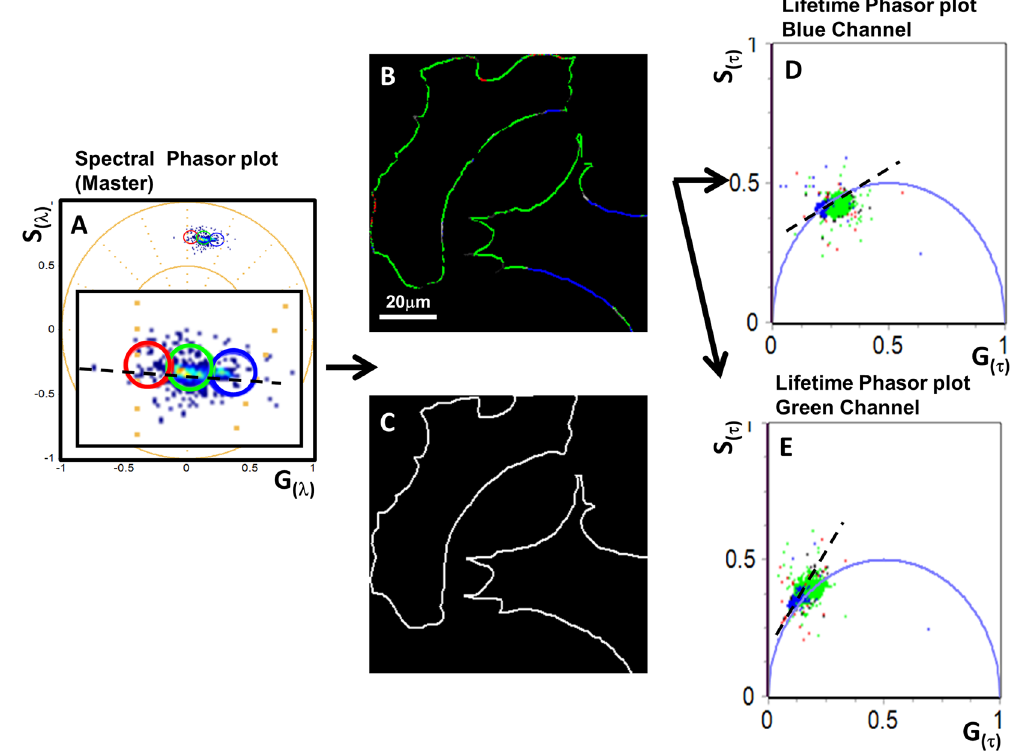
Figure 4. Multi-D phasor analysis of the LAURDAN fluorescence in NIH-3T3 plasma membranes. ( A ) Spectral phasor plots (master) and cursor selection (red, green and blue) of different ROI in the master (spectral) phasor plot. ( B ) Color-coded images generates by the cursor selection according to the master phasor plot. ( C ) Mask used by the analysis shown in B . ( D , E ) Lifetime phasor plots (blue and green channels, see Material and Methods for the channel transmission